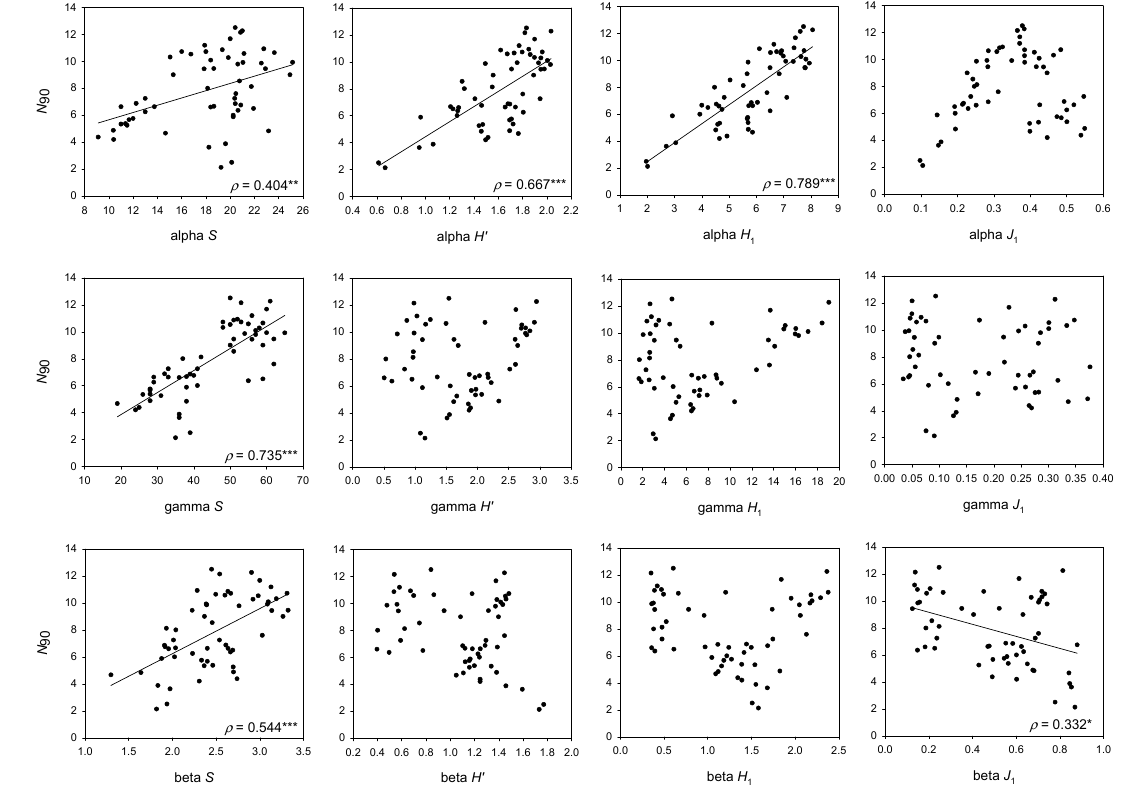
Figure 3. Results of the linear regression analysis of N 90 with alpha, beta and gamma versions of Species Richness ( S ), Shannon ( H’ ), Hill number of order 1 ( H 1 ) and the derived evenness measure ( J 1 ), considering the whole bathymetric range (50–800 m depth). The results for alpha, beta and gamma versions of J ’ are not plotted because they do not show any correlation with N 90 . Spearman’s rank correlation coefficient ( ρ ), and p -values are presented. (*) p < 0.05; (**) p < 0.01; (***) p <